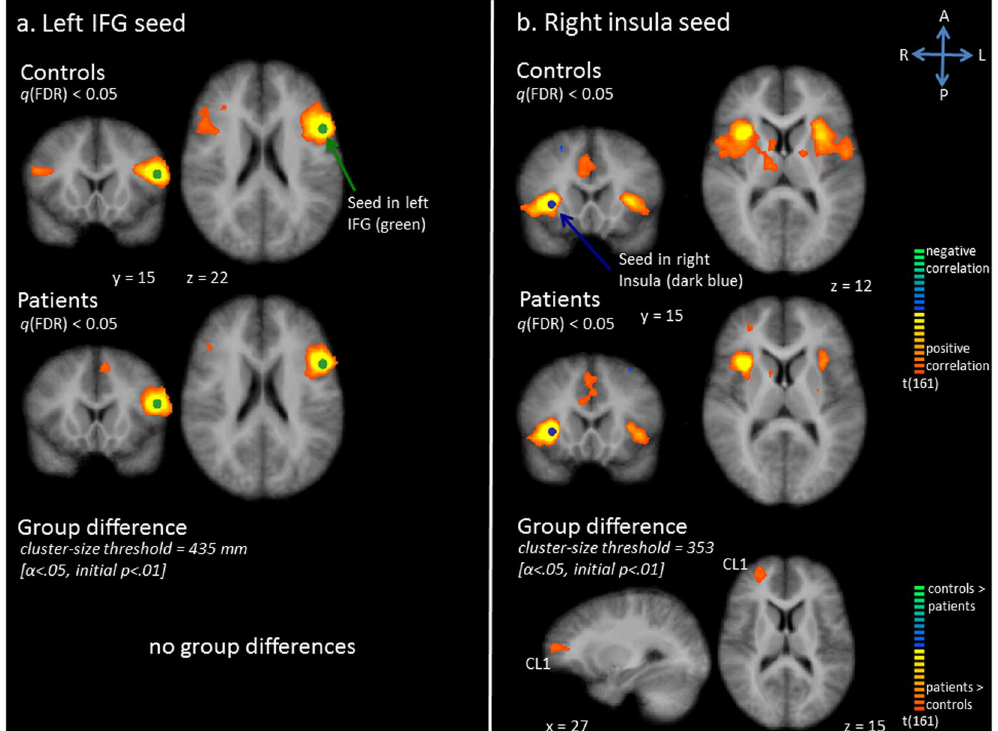
Figure 3. Functional connectivity (Fc) maps for the left inferior frontal gyrus (IFG) seed (panel a) and right insula seed (panel b). Upper and middle row: Statistical maps resulting from the seed-based correlation analysis separate per group. Seeds are overlaid in green (left IFG seed) or dark blue (right insula seed). Maps are thresholded at q (FDR) < 0.05. Lower row: Group differences in functional connectivity per seed region (red indicates patients show increased connectivity as compared to controls, blue indicates patients show decreased connectivity as compared to